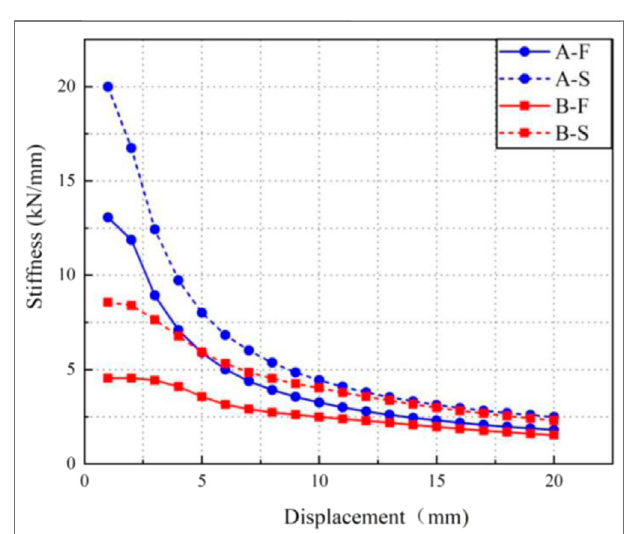
FIGURE 14 | Stiffness degradation